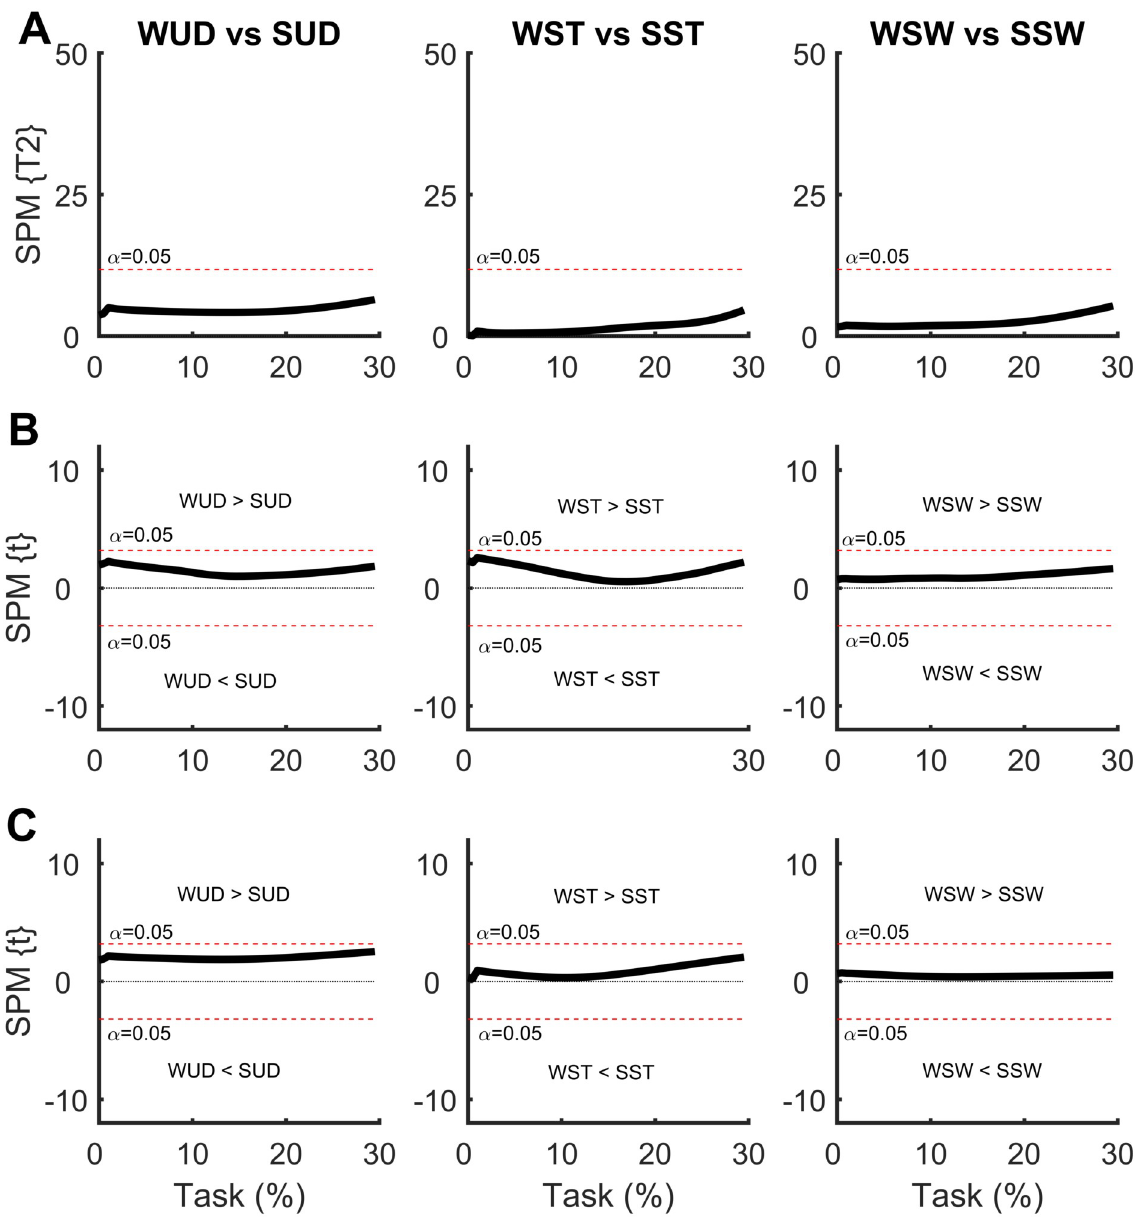
Fig 9. (A) Hotelling’s paired T-square test on the center of mass (COM) displacement vector comparing the weight positioned at the waist with the weight positioned at the shoulder. Post hoc scalar t-tests on (B) medial-lateral (ML) COP and (C) anterior-posterior (AP) COP components. WUD and SUD: weight uniformly distributed at the waist and shoulder, respectively; WST and SST: weight positioned at the waist and shoulder, respectively, on the stance foot side; WSW and SSW: weight positioned at the waist and shoulder, respectively, on the swing foot